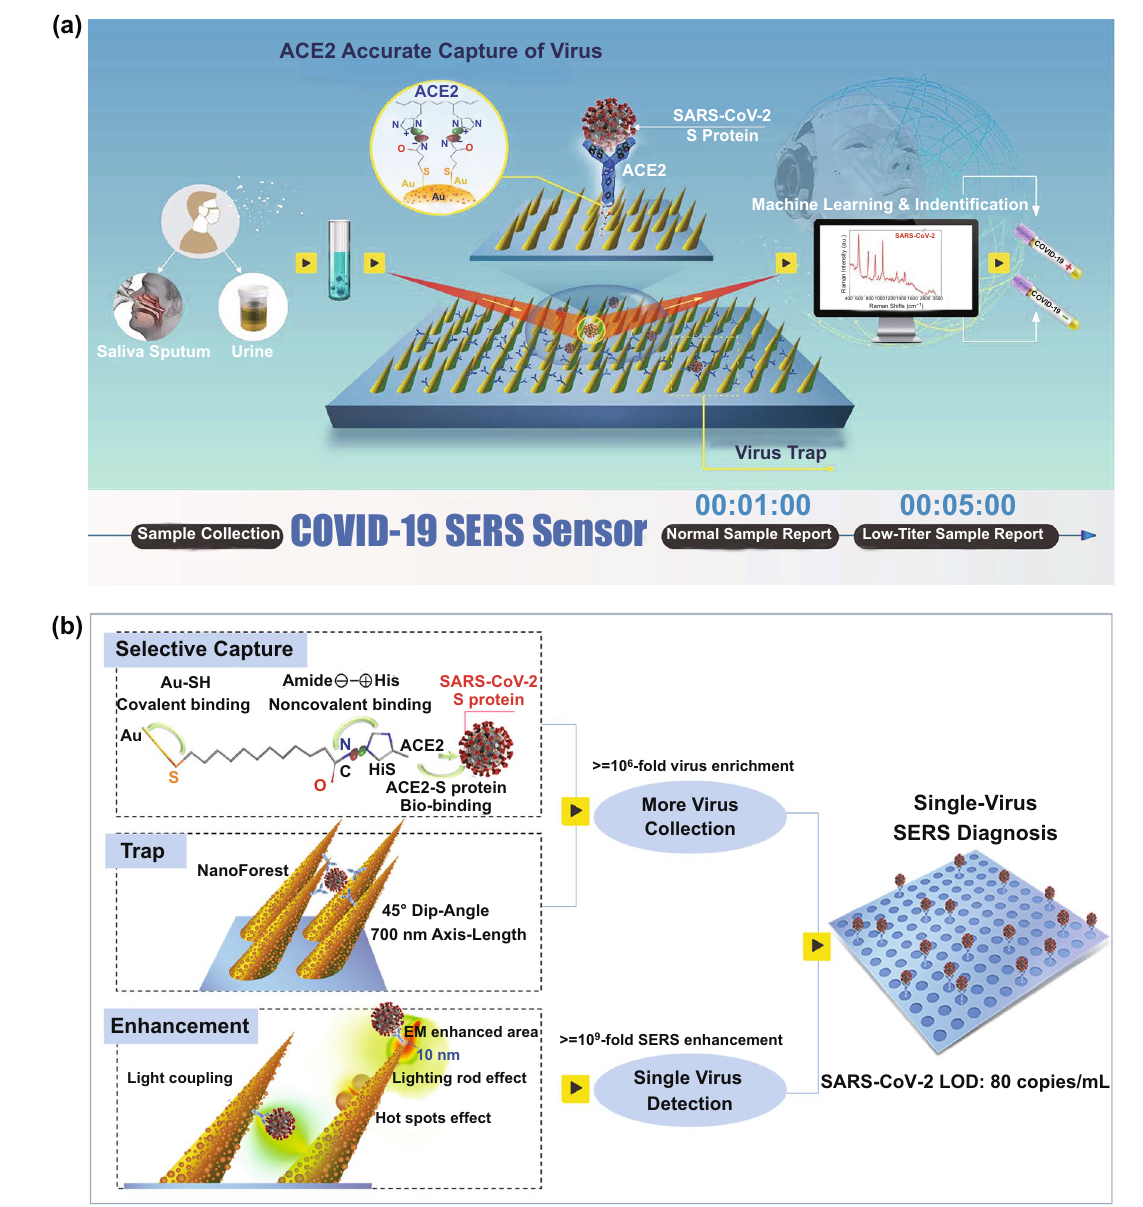
Fig. 1 Schematic diagram of COVID‑19 SERS sensor design and single‑virus detection mechanism. a Schematic diagram of COVID‑19 SERS sensor design and operation procedure. SARS‑CoV‑2 can be localized by “virus‑traps” nanoforest composed of oblique gold‑nanoneedles array (GNAs), and be captured by ACE2 anchored on amide‑modified GNAs from virus‑containing urines even with complex multi‑proteins circum‑ stance. Through machine‑learning and identification techniques, the identification standard of virus signals are established, and utilized for virus diagnoses. b Schematic diagrams of single‑virus detection by selectively capturing and trapping virus, and the multi‑SERS enhancement mecha‑